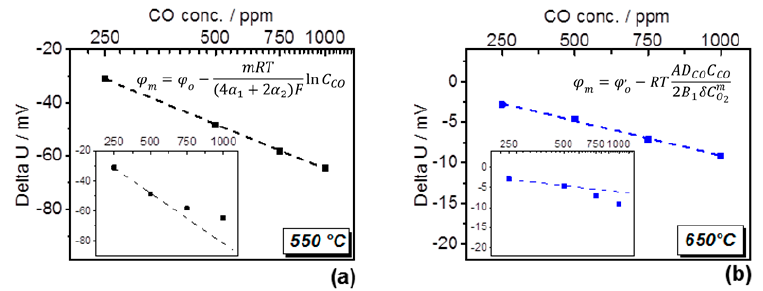
Figure 5. Type I sensor: ( a ) dependence of delta U on CO conc. at 550 °C on logarithmic and linear (inset) scale, and its mathematical expression; ( b ) dependence of delta U on CO conc. at 650 °C on linear and logarithmic (inset) scale, and its mathematical